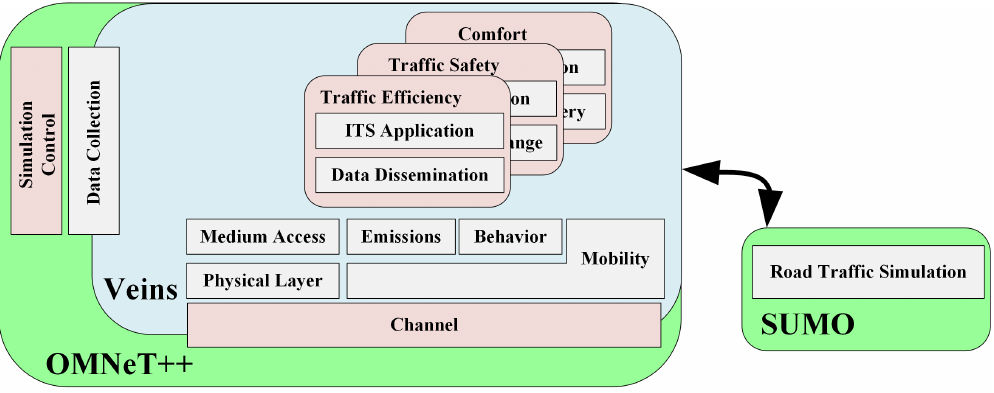
Figure 6. Simulation platform